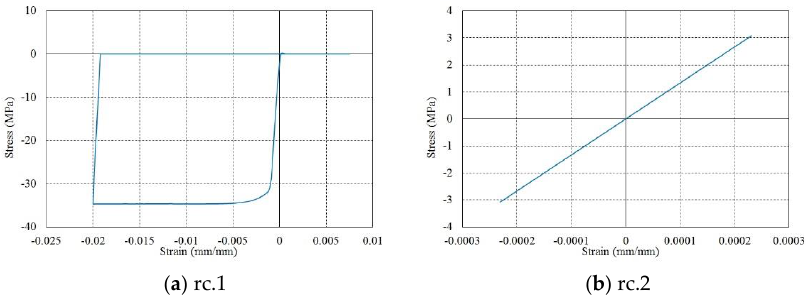
Figure 13. Stress–strain responses from local tests rc.1 and rc.2.